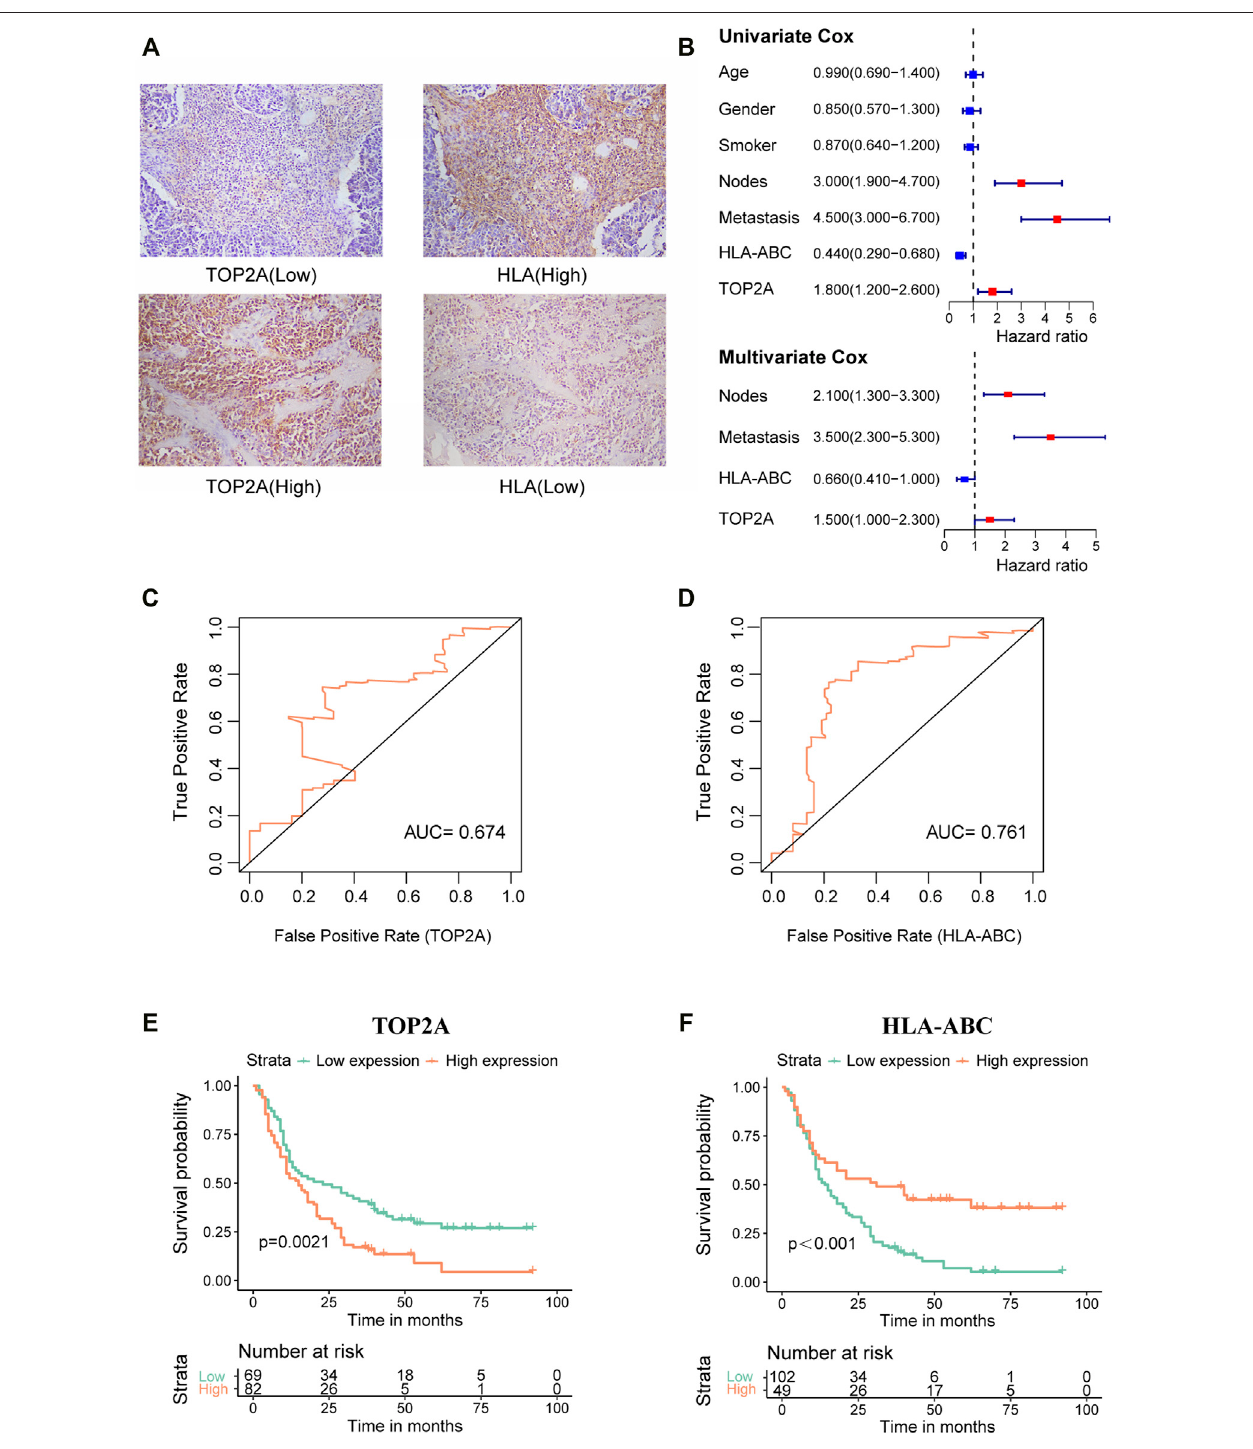
FIGURE 10 | Veri fi cation of TOP2A and HLA-ABC expression by immunohistochemistry in our SCLC cohort. (A) Representative immunohistochemical pictures of TOP2A and HLA-ABC in SCLC tissue sections. (B) Forest plot for univariate and multivariate Cox regression analysis. (C,D) Time-dependent receiver operating characteristic curves of TOP2A and HLA-ABC . (E,F) Kaplan – Meier survival curve for 151 SCLC patients strati fi ed by the cutoff values of TOP2A and HLA-ABC , respectively.